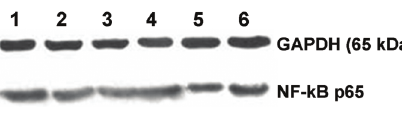
Figure 4. Western blot detection of the NF- k B p65 protein content of the heart, lung, and kidney tissues of male pigs induced with acute respiratory distress syndrome that received continuous veno-venous hemo fi ltration therapy (experimental) or conven- tional supportive therapy (control). The numbers 1, 3, and 5 exhibit the NF- k B p65 protein content of the heart, lung, and kidney tissues of the control group, respectively; 2, 4, and 6 exhibit the NF- k B p65 protein content of the heart, lung, and kidney tissues of the experimental group,